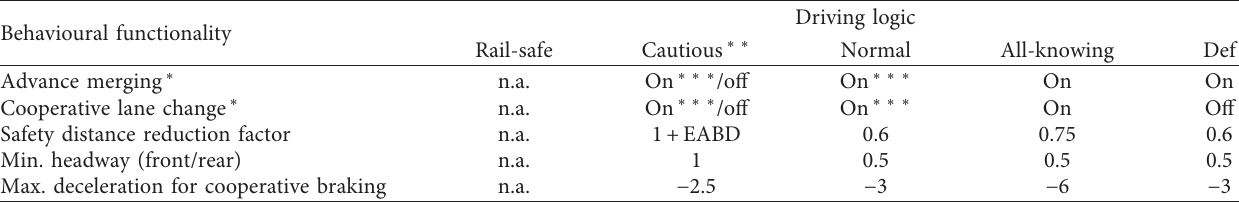
Table 4: Recommended driving behaviour parameters for lane change in